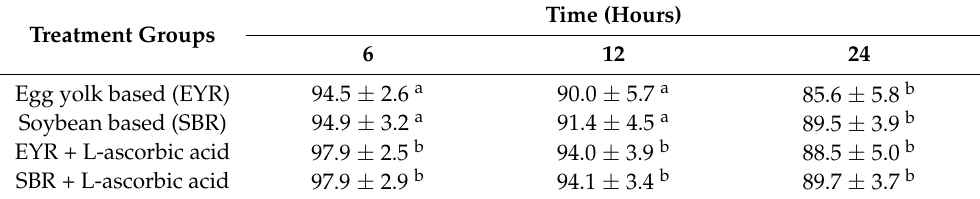
Table 4. Viability (%) of turkey spermatozoa over 24 h at 4 ◦ C. Treatment Groups